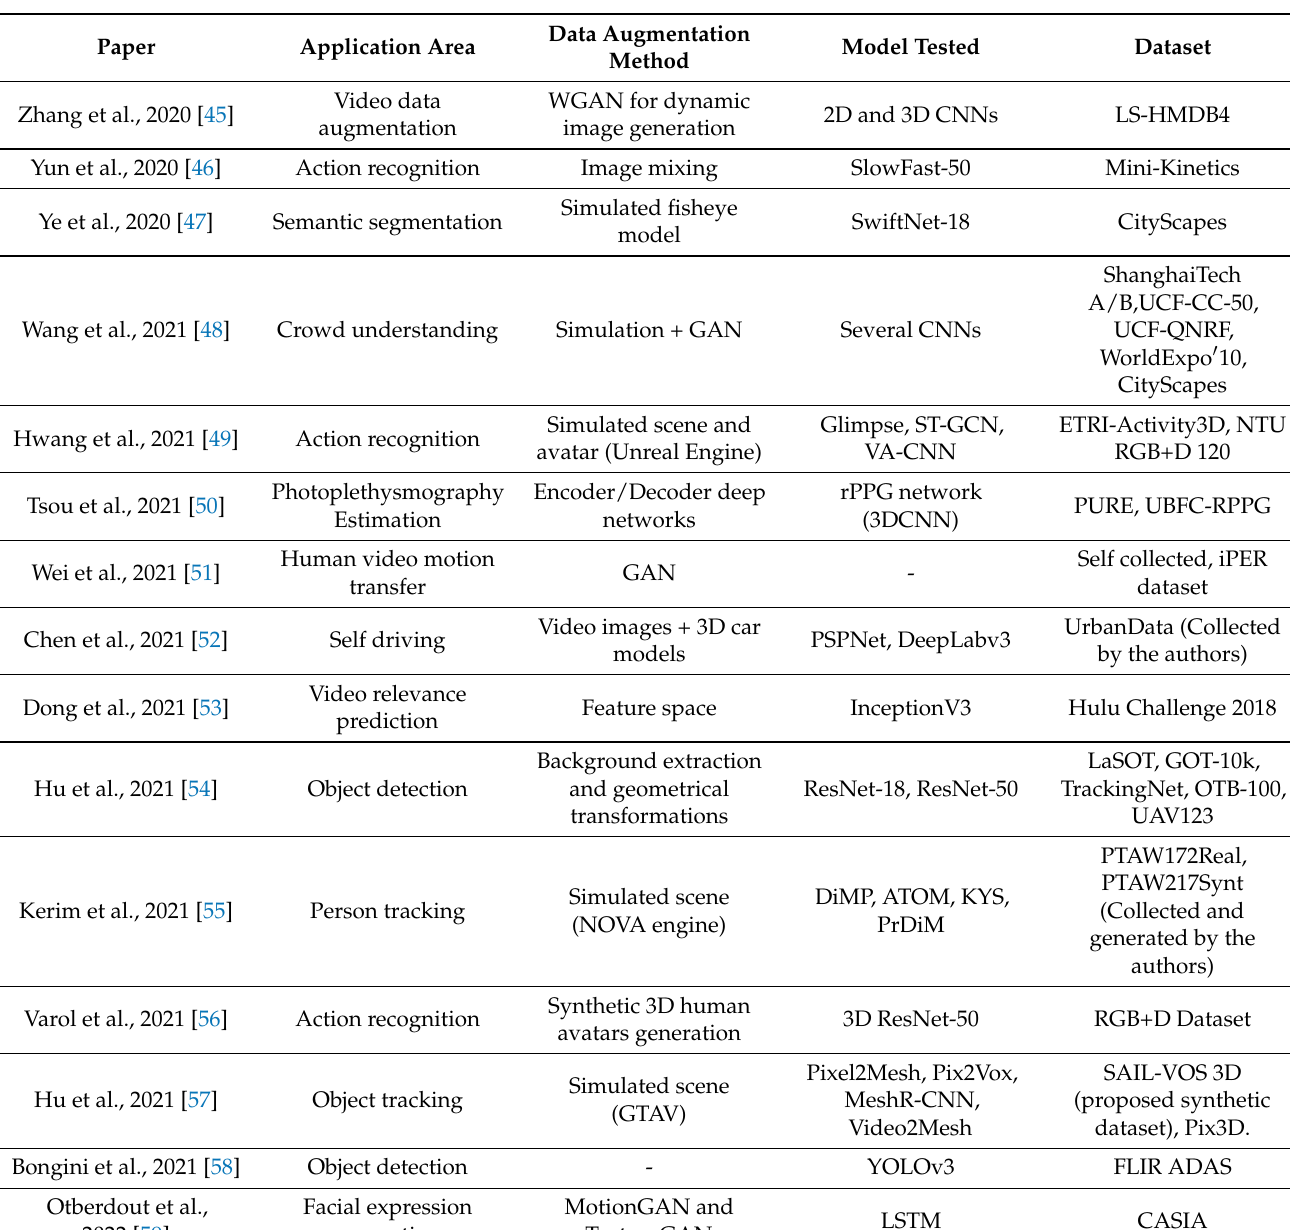
Table 2. List of the reviewed papers part 2. The last 15 papers ordered by year of publication. Please read the analysis of the papers in Section 3 for a better understanding of the